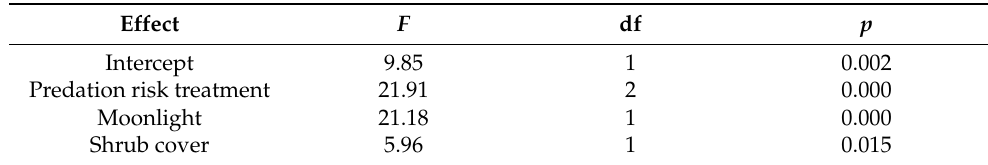
Figure 2. Abrothrix spp. behaviors. Mean fast locomotor activity (s) ± SE depending on ( a ) moonlight and ( b ) shrub cover thickness. Mean slow locomotor activity (s) ± SE depending on ( c ) moonlight and ( d ) shrub cover thickness. Mean vigilance time (s) ± SE depending on moonlight ( e ). Table 3. Results of the GLM analyzing the effect of experimental and environmental factors on Abrothrix spp. slow locomotor activity.